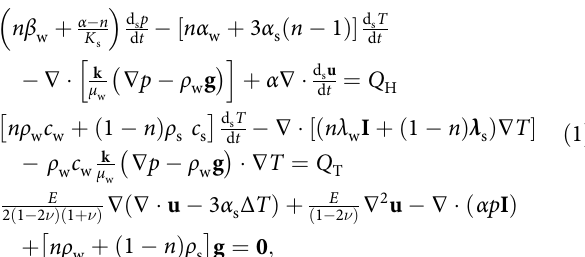
stress and s ¼ σ 0 (cid:3) I σ 0